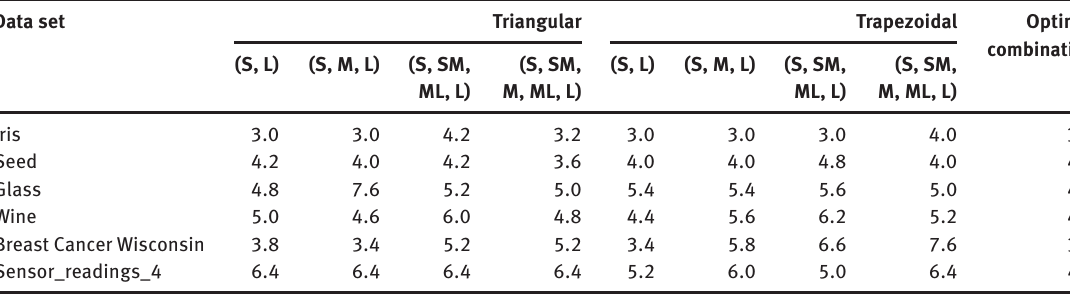
Table 8: Number of Rules with Different Combinations of MFs and Number of Linguistic Terms. Data